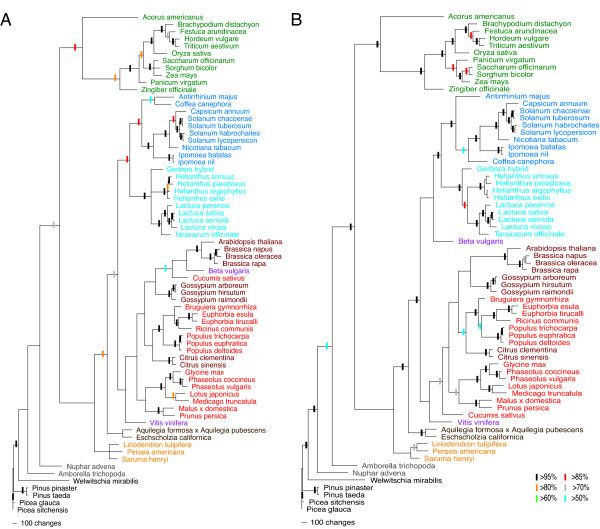
Single copy nuclear genes improve phylogenetic resolution in the Brassicaceae. A single most-parsimonious tree was found from combined analysis of complete data-matrix containing genes At2 g32520, At2 g13360, and At5 g23290 (L = 961, consistency index = 0.774, retention index = 0.529). Bootstrap values are shown above branches. Note that individual gene trees gave similar topologies. The phylogeny is consistent with published phylogenies using more taxa and other molecular markers. Bootstrap values from Beilstein et al., 2006 are shown below branches.